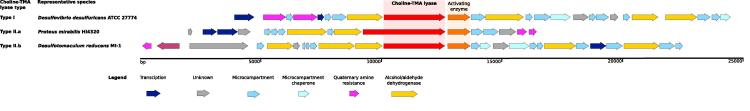
Alignment of the cut gene clusters for bacterial isolates representative of the three choline-TMA lyase (cutC) types [19]. The clusters are aligned to the homologous regions of the glycyl radical enzyme (GRE), cutC and activating enzyme, cutD. Gene functions are denoted by colour and the legend shown at the bottom.